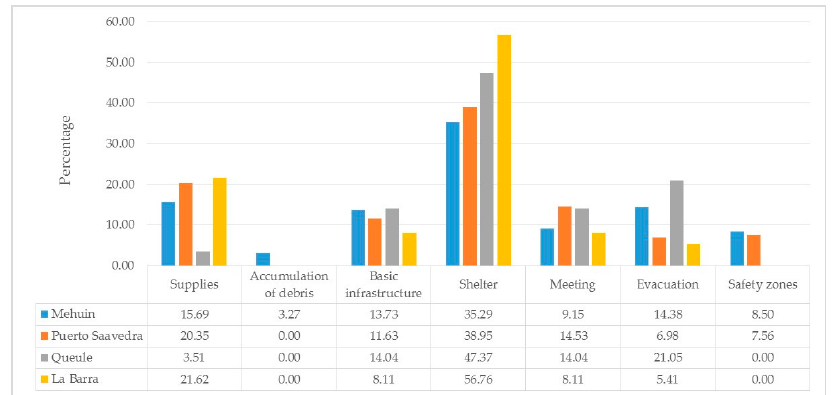
Figure 4. Frequency of mention of uses for each town.